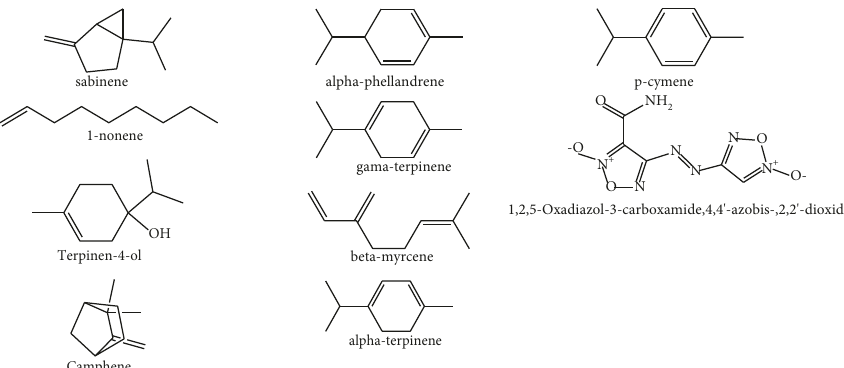
Figure 1: The major constituents of EO of S . gigas stem bark.